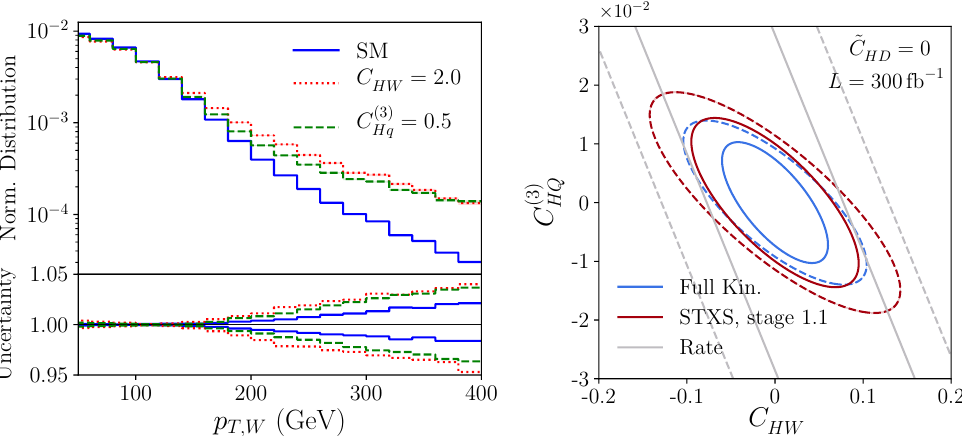
Figure 11 . Left: the normalized distributions of p T;W for signal and background weights with various choices of the theory parameters and (barely visible) shaded bands showing the e(cid:11)ects of the PDF and scale uncertainties. Right: the 95% CL bounds on C HW and C (3) in the Fisher information Hq approximation obtained with the Sally estimator evaluated using the full set of physical variables (blue), the Stage 1.1 simpli(cid:12)ed template cross sections (red), and measurements of the rate (grey), with ~ C HD (cid:12)xed to zero. The solid lines show the projected limits obtained in the absence of systematic uncertainties, while the dashed lines show the reach contours after marginalizing over the additional nuisance